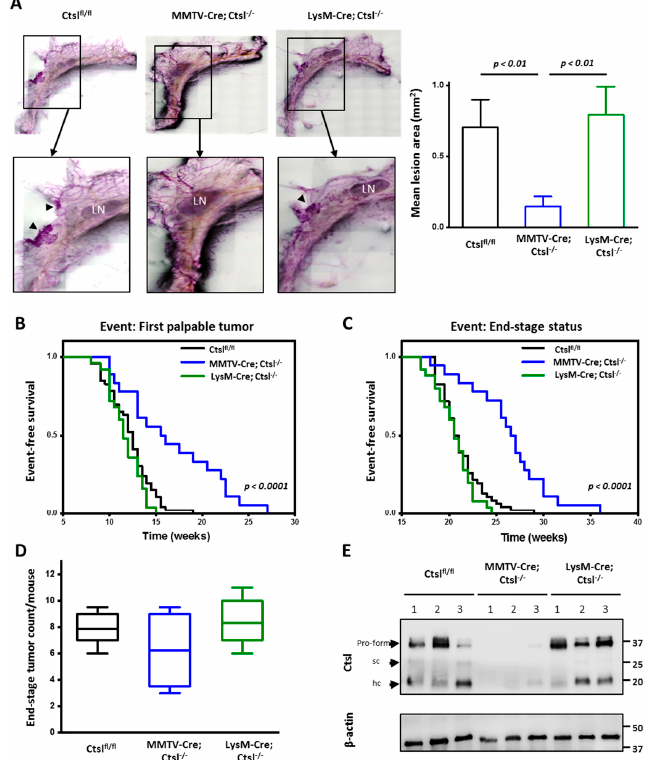
Figure 1. Ctsl deletion in epithelial cells of mammary tumors delay tumor onset. ( A ) Representative images of mammary gland whole mounts of 8-week-old female mice bearing the PyMT +/T antigen and their respective magnification, showing emerging locally-restricted hyperplasia in Ctsl fl/fl and LysM-Cre/ Ctsl − / − mice. LN, lymph node; arrowheads indicate hyperplasia. Whole mounts were imaged at 4x magnification in an automated manner and stitched together by software; thus, scale bars were not applicable. Quantification of premalignant lesions shows a significant decreased area in MMTV-Cre/ Ctsl − / − mice ( p < 0.01, Mann–Whitney) ( Ctsl fl/fl n = 9; MMTVCre/ Ctsl − / − n = 11; LysM-Cre/ Ctsl − / − n =